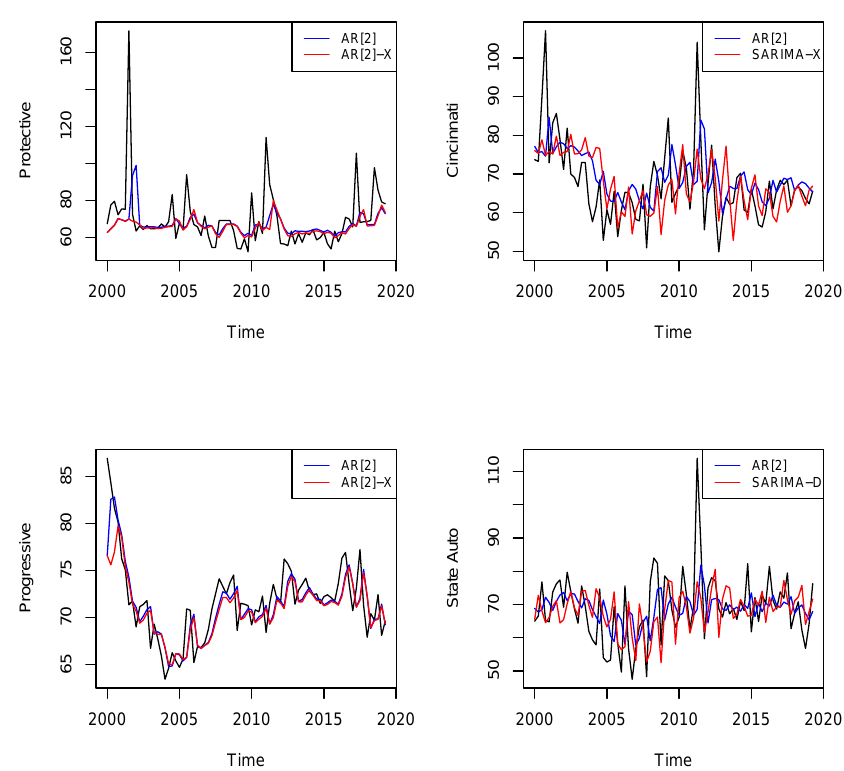
Figure 5. One-quarter ahead loss ratio forecasts for four insurance companies: 2000/Q1–2019/Q2. (Note: Throughout, real data displayed in black. According to our results, forecasts from intervention models outperform AR[2] forecasts for the companies Protective, Cincinnati, and State Auto. This situation changes in the case of Progressive with superior AR[2]